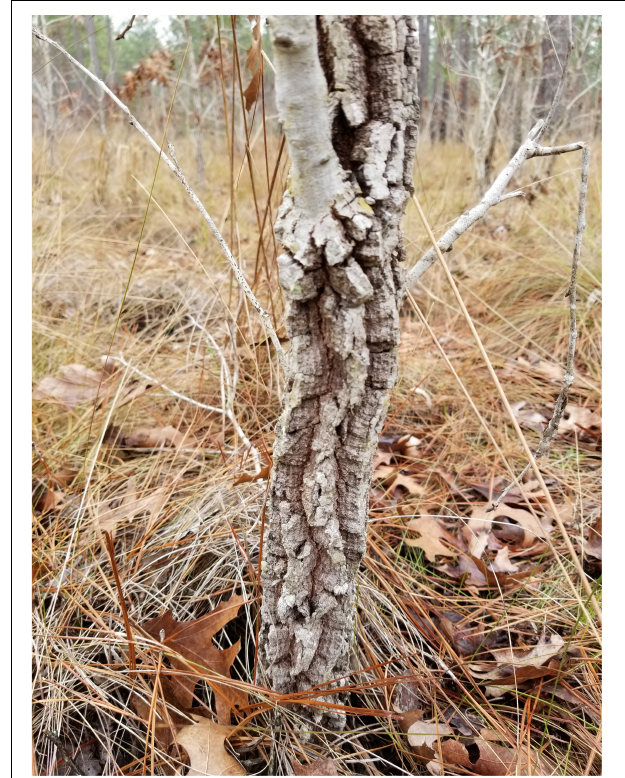
FIGURE 1 | Turkey oak ( Quercus laevis ) develops thick rugose bark even in small diameter